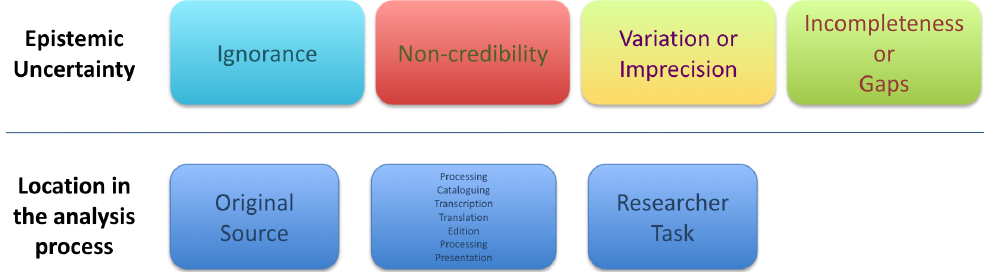
Figure 2. The two dimensions of the matrix of uncertainty for the DH that was built during the first workshop: type of epistemic uncertainty ( top , as per Simon et al.’s types) and location in the DH data analysis process where it originates ( bottom